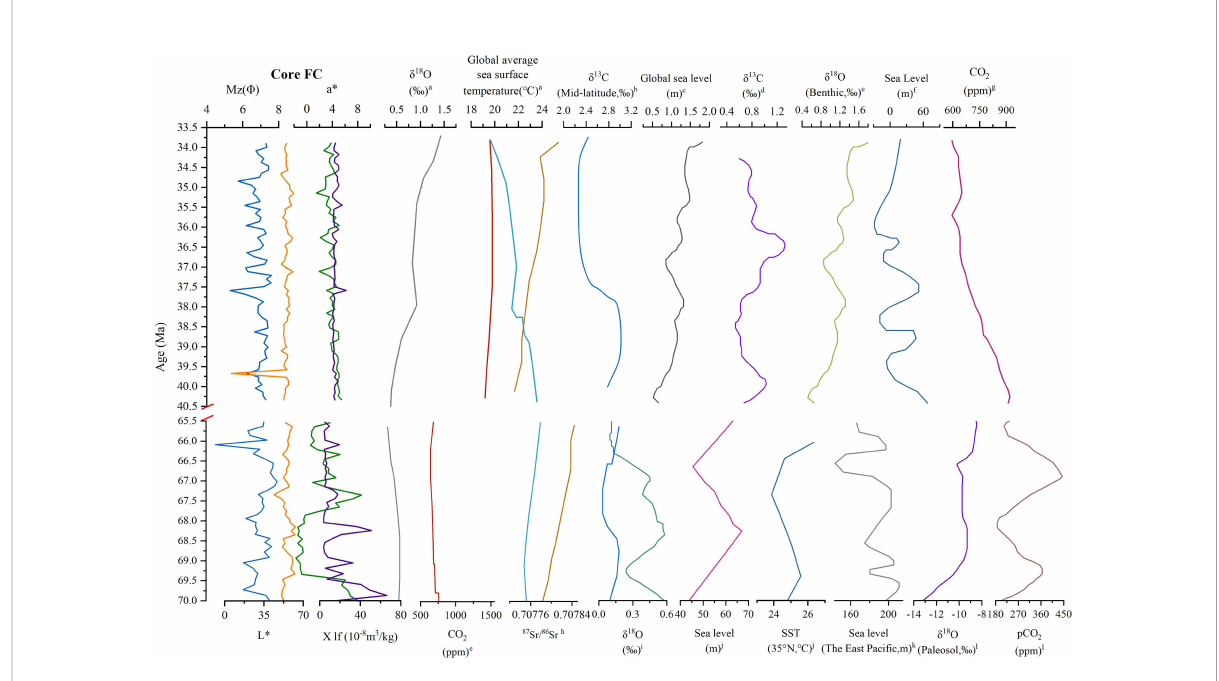
FIGURE 7 Response of substitutive indexes of borehole sediments from FC borehole in Neogene and Late Cretaceous to climate and sea level changes records. The geological record curves separately from: Mills et al., 2019 (a);Prokoph et al., 2008 (b); Lin and Sun, 1985 (c); Westerhold et